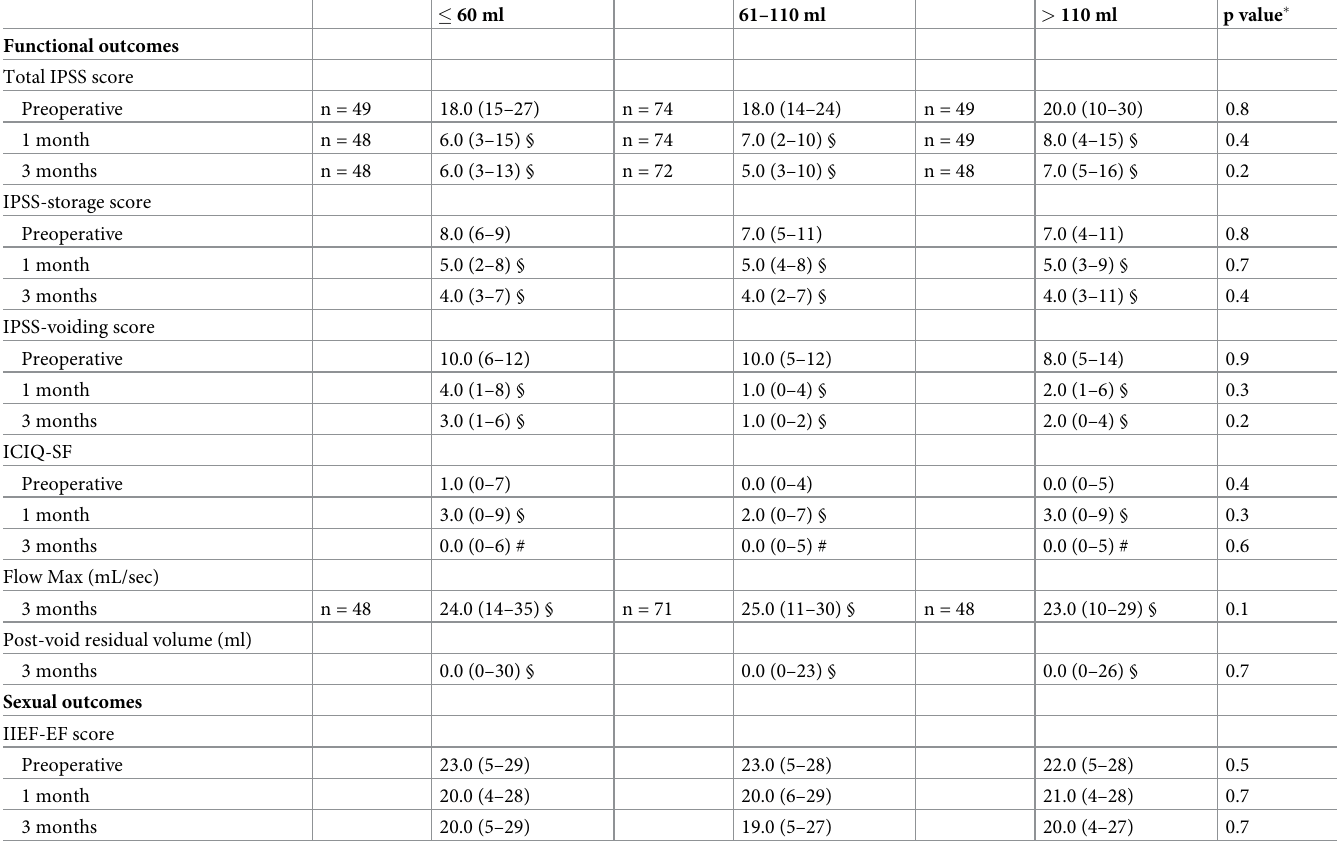
Table 3. Functional and sexual characteristics of the whole cohort of patients as segregated according to prostate size [median (IQR)].